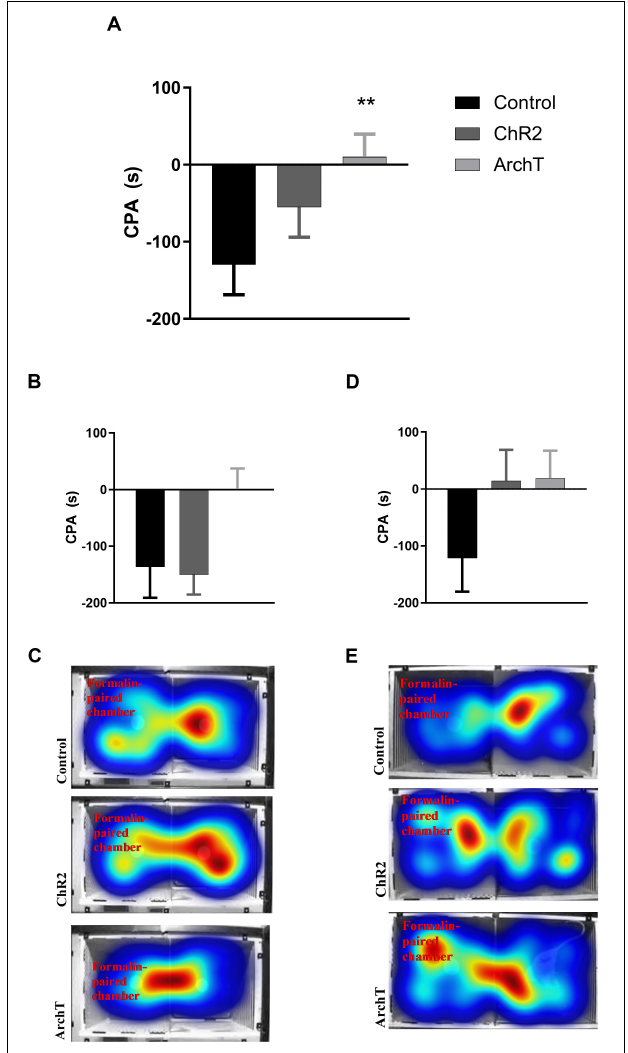
FIGURE 4 | (A) Effects of optogenetic stimulation (ChR2) or inhibition (ArchT) of glutamatergic neurons in the ACC on formalin-induced conditioned place aversion (F-CPA) in combined male and female Sprague-Dawley rats. Data are mean ± SEM ( n = 7–11 per group). ** p < 0.01 vs control. (B) Effects of optogenetic stimulation (ChR2) or inhibition (ArchT) of glutamatergic neurons in the ACC on formalin-induced conditioned place aversion (F-CPA) in male Sprague-Dawley rats. Data are mean ± SEM ( n = 8–10 per group). (C) Representative heat map images of post-conditioning trials for each treatment group in male rats. (D) Effects of optogenetic stimulation (ChR2) or inhibition (ArchT) of glutamatergic neurons in the ACC on formalin-induced conditioned place aversion (F-CPA) score of female Sprague-Dawley rats. Data are mean ± SEM ( n = 7–11 per group). (E) Representative heat map images of post-conditioning trials for each treatment group in female